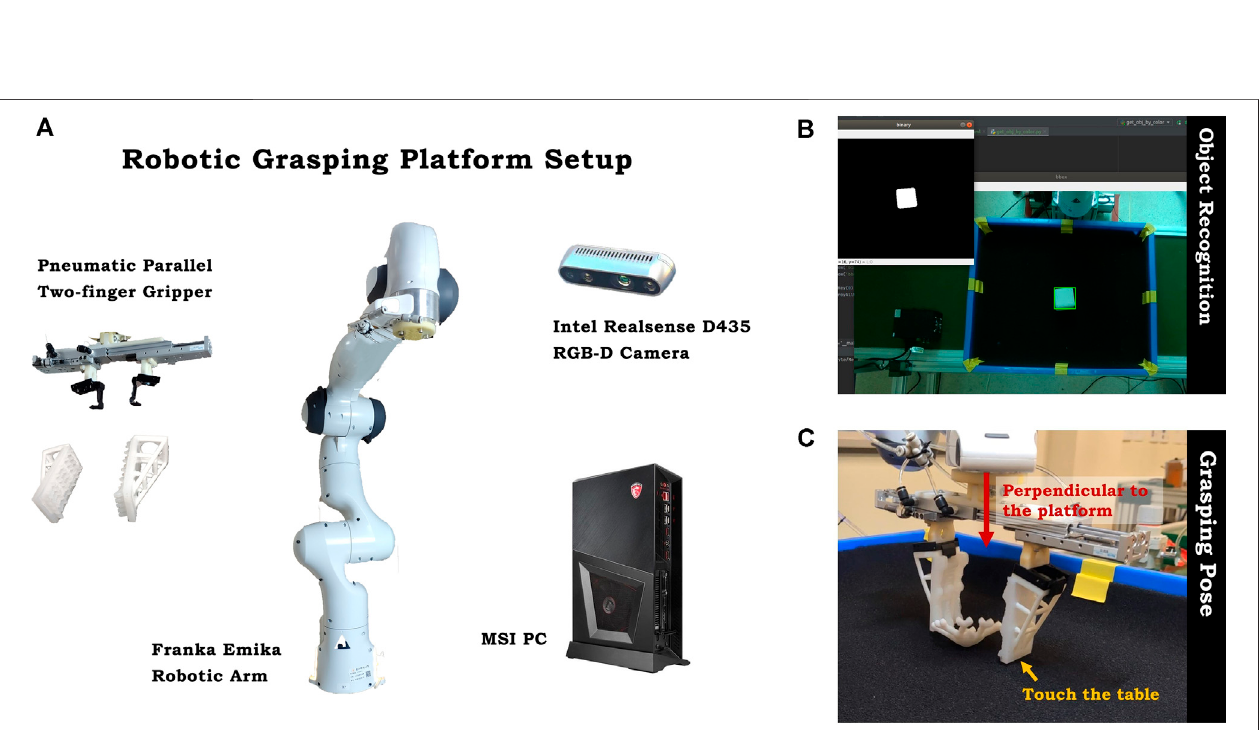
FIGURE 4 | (A) The setup of the automatic robotic manipulation platform for the experiment. (B) Object recognition on the platform. (C) The perpendicular grasp pose for the gripper, with the fi ngers touching the surface of the platform.